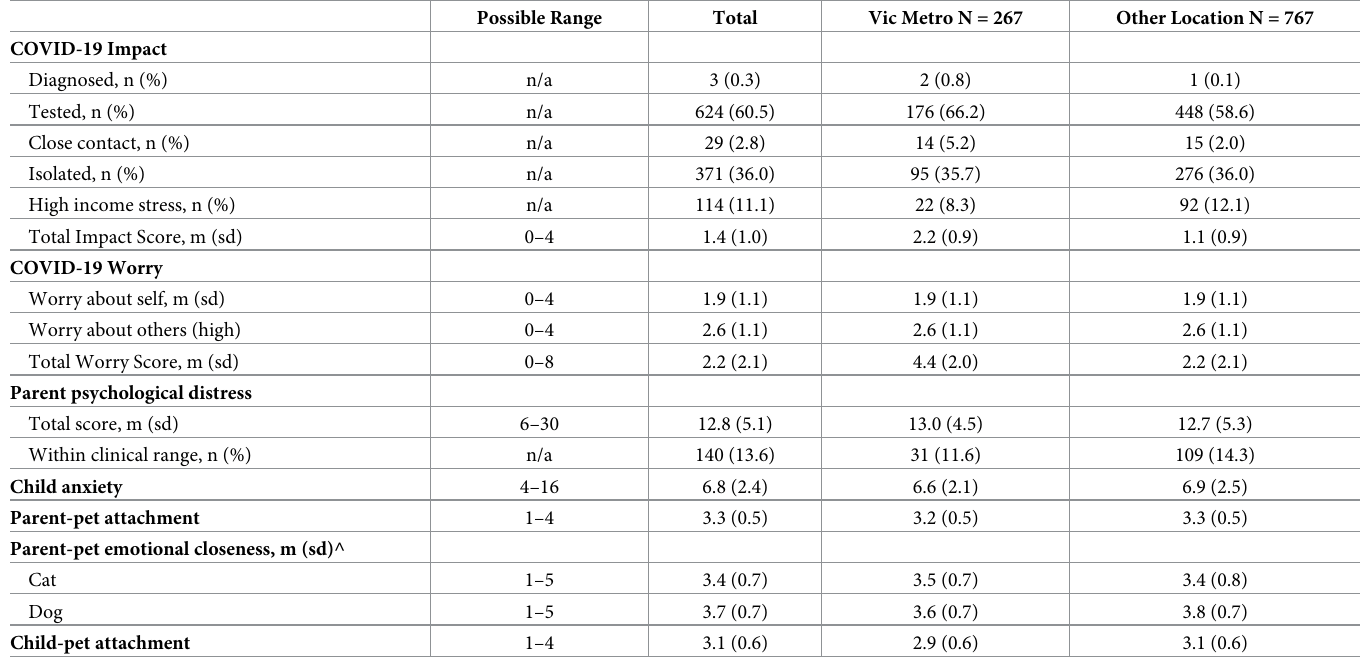
Table 2. Sample descriptives for COVID-19 impact, worry, parent and child mental health, and parent and child attachment to pet ( n =